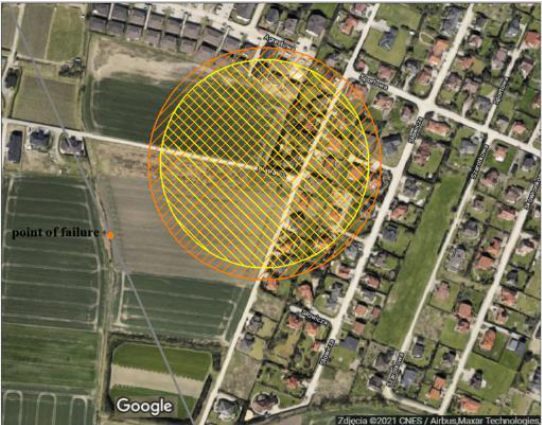
Figure 25. Hazard zones due to an explosion for a natural gas pipeline (a = 0.2, L = 200 m): yellow zone, p = 1 MPa; orange zone, p = 5 MPa.